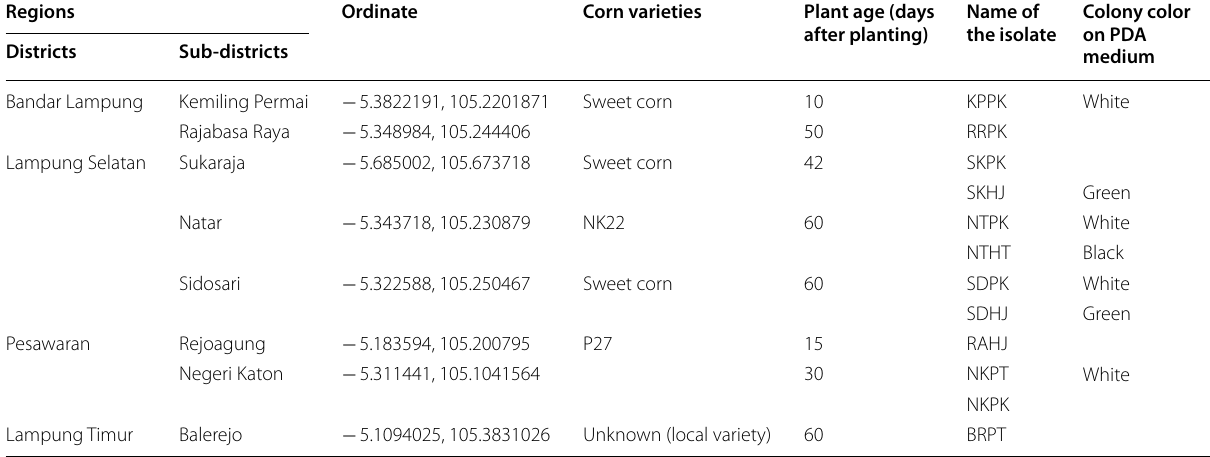
Table 1 Fungal isolates obtained from infected Tenebrio molitor Regions Ordinate Corn varieties Plant age (days